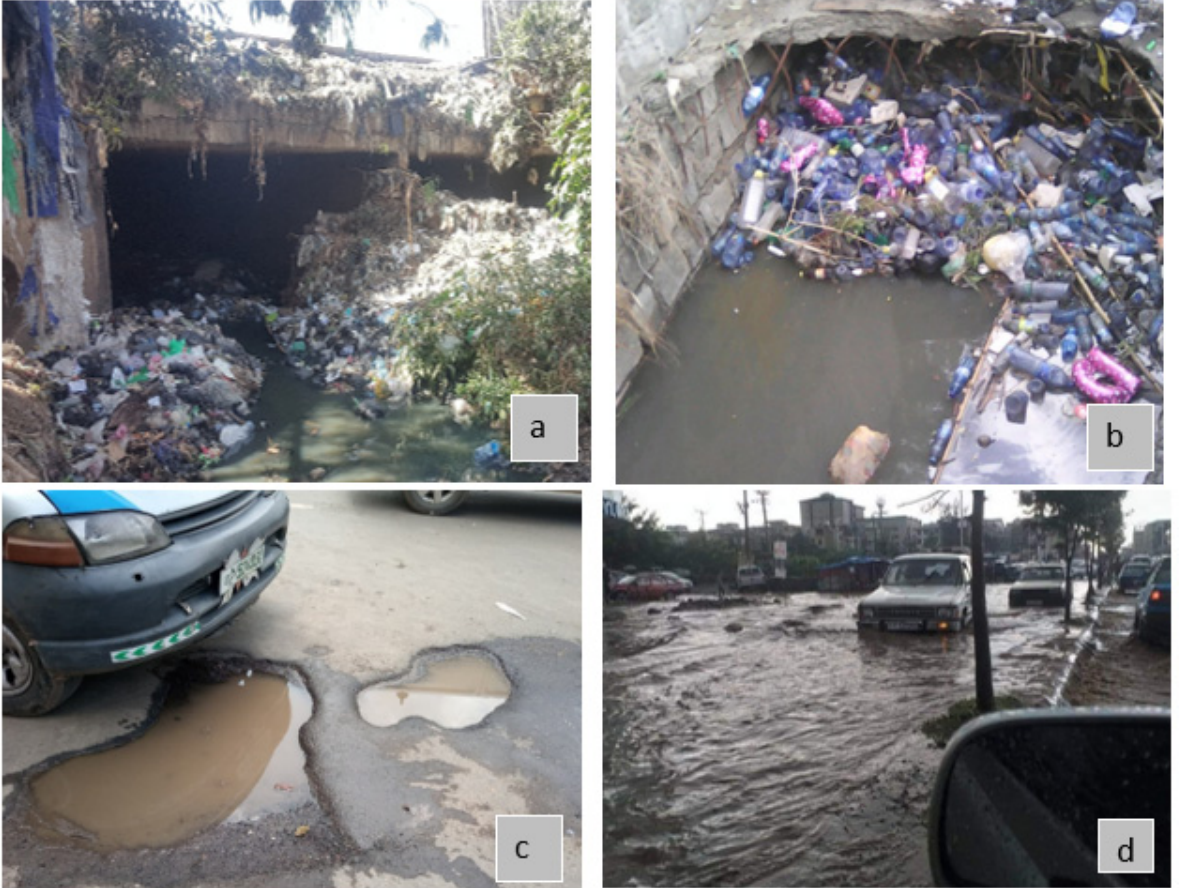
Figure 11. Solid wastes, dominant drainage failure causes ( a , b ), the impacts of poor drainage by creating potholes ( c ), and traffic disruption due to surface flooding ( d ).